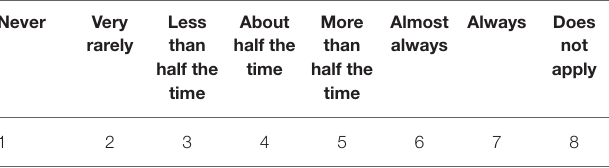
TABLE 2 | Response range for the children’s behavior questionnaire. Never Very